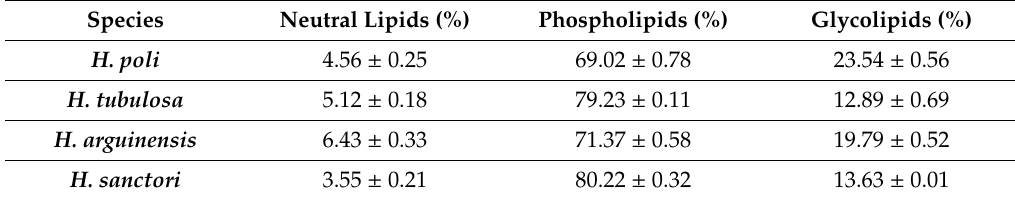
Table 2. Lipid classes of the body wall of the studied sea cucumbers (%) by Iatroscan. Mean ± SD [ n =